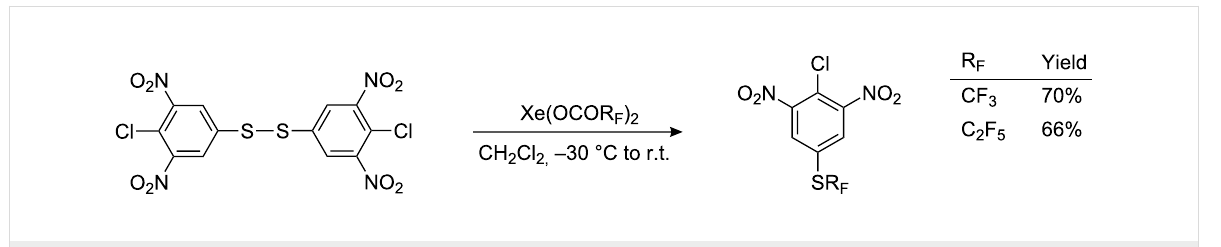
Scheme 60: Interaction of Xe(OCOR F ) 2 with nitroaryl disulfide [227].